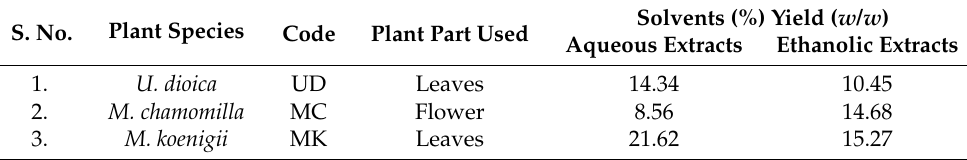
Table 1. The percentage yield of plant extracts using aqueous and ethanolic extraction